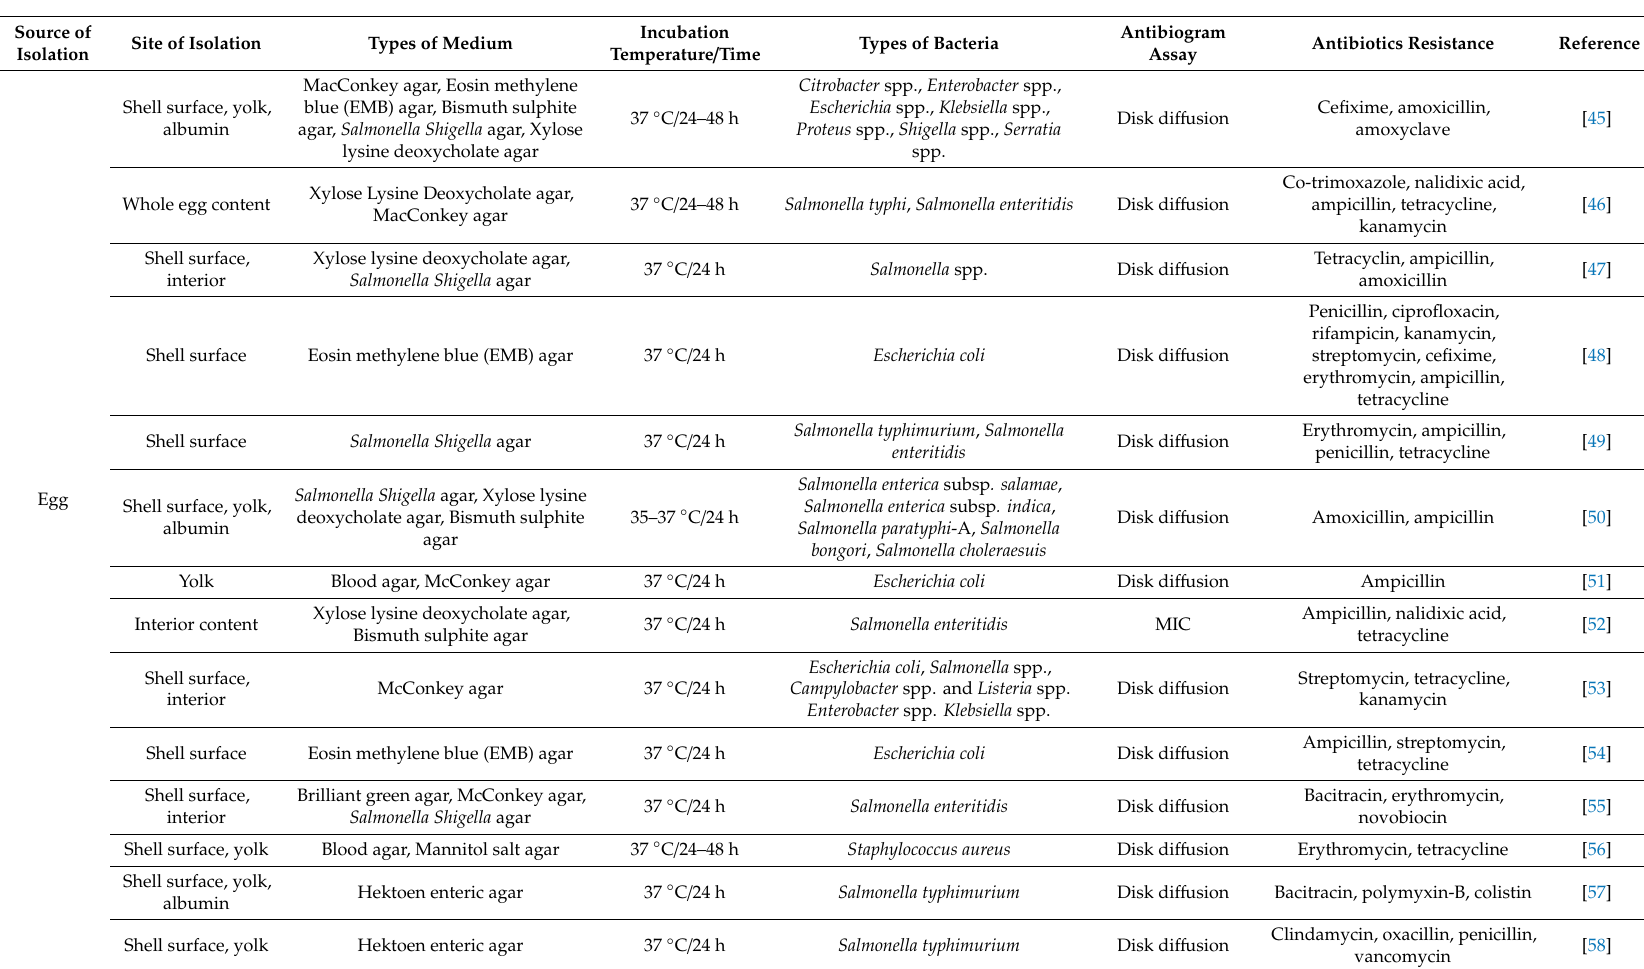
Table 3. Isolation and identification of pathogenic bacteria using di ff erent selective and deferential media along with their antibiotic resistance pattern. Source of